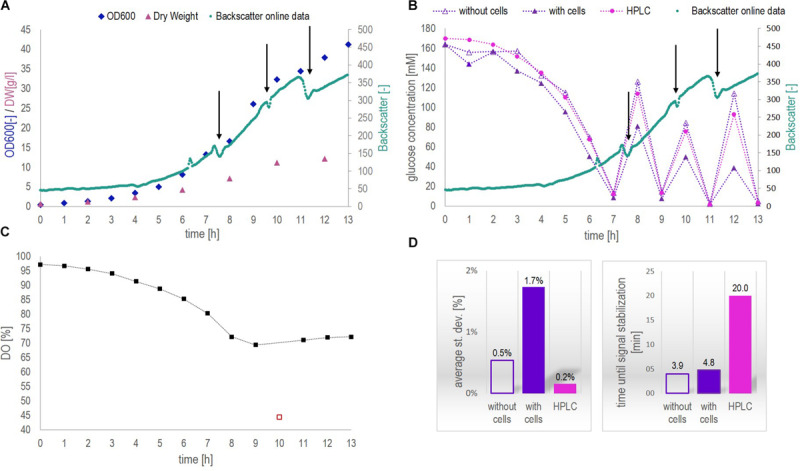
Data collected from fermentation 1 during at-line application of biosensor chip 1. (A) Biomass concentration as a function of time measured by optical density (OD600, at-line) and dry weight (DW, off-line) as well as continuously on-line via the CGQBIOR (backscatter units). (B) Glucose concentration measured at-line with and without cells by means of the biosensor platform as well as off-line (cell-free samples) by HPLC. The addition of glucose during the fermentation is indicated by black arrows. Besides, the increase in biomass over time is demonstrated by backscatter measurements as in Figure 4A. (C) Dissolved oxygen (DO) profile over the fermentation course. The red square must be considered as an outlier. (D) Average st. dev. and average time until signal stabilization (time until measurement result) of the different glucose measurements performed.